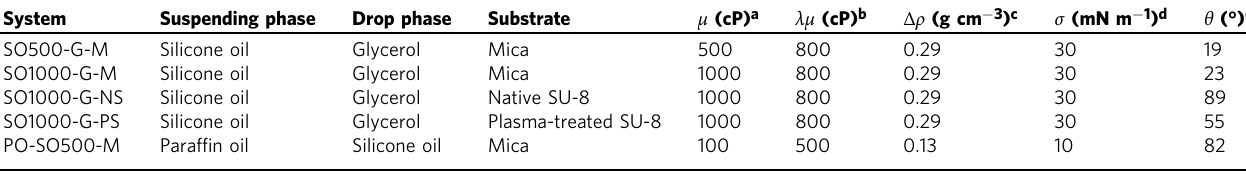
Table 1 Liquid combinations and substrates employed in the